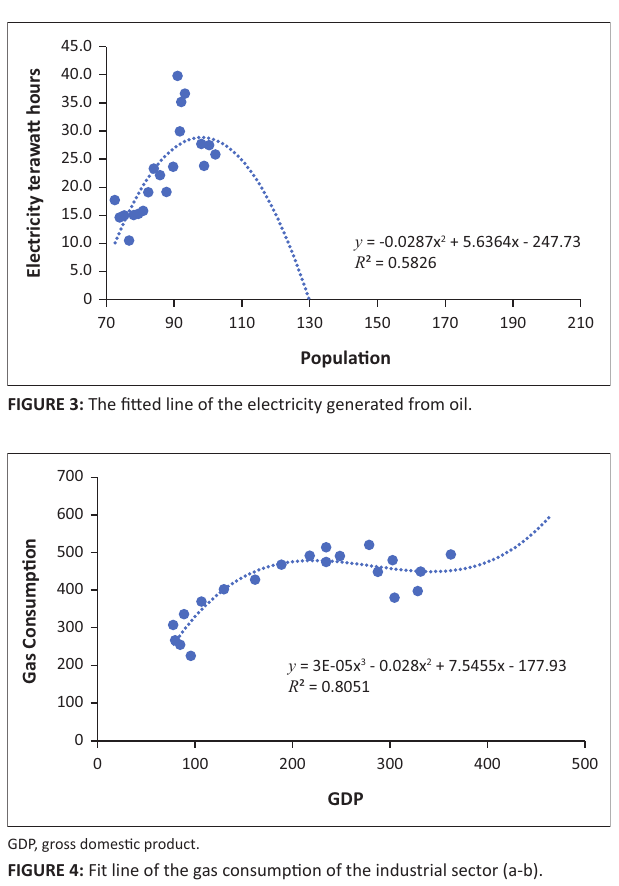
FIGURE 4: Fit line of the gas consumption of the industrial sector